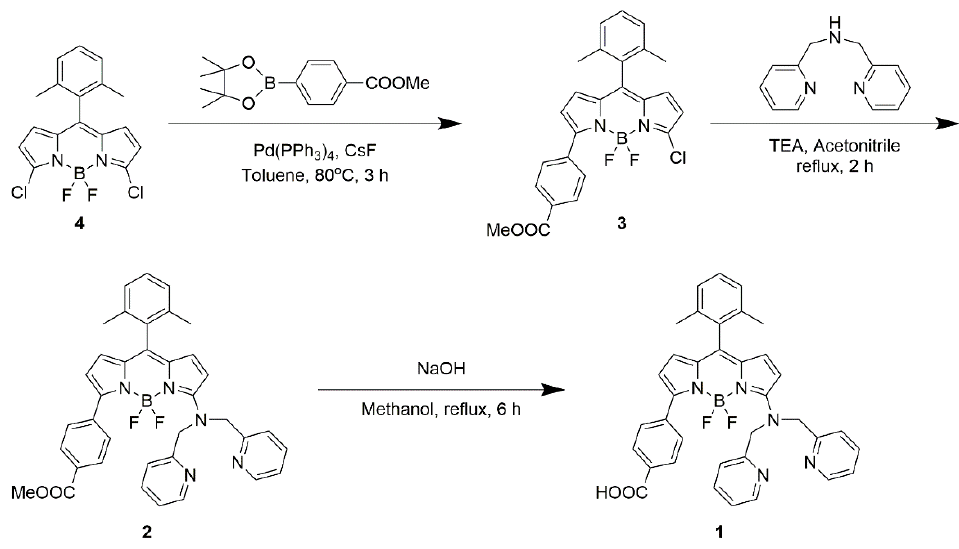
Figure 1. Synthetic route to BODIPY 1 .